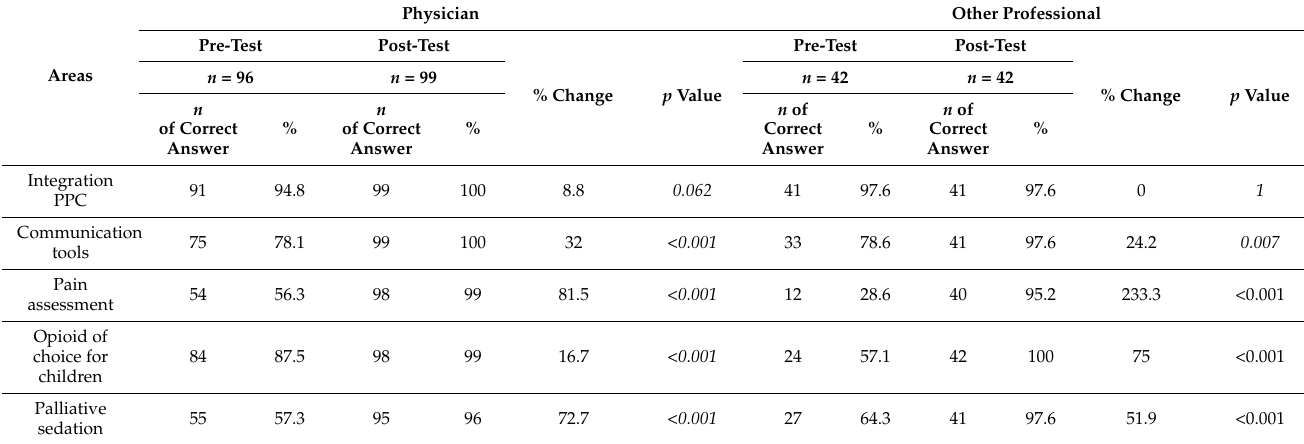
Table 3. Pre-test and post-test score of palliative care knowledge by